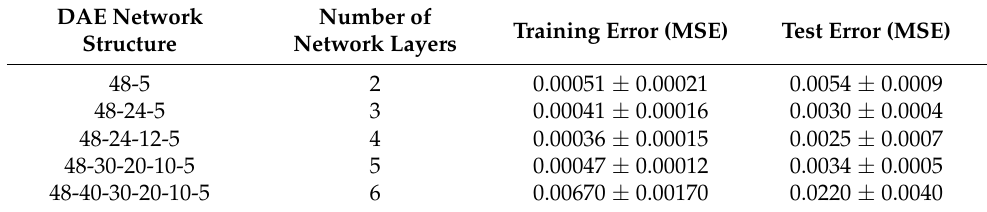
Table 1. The prediction effect of using different depths of DAE